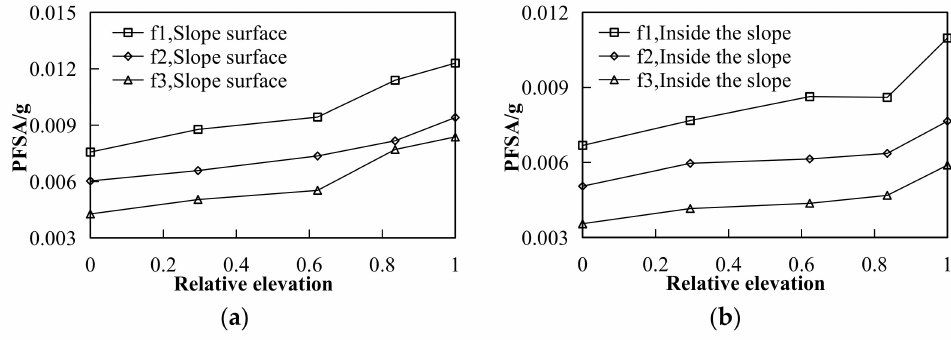
Figure 15. The PFSA change rule of the bedded slope when input WE wave in the x direction: ( a ) at the slope surface, ( b ) inside the